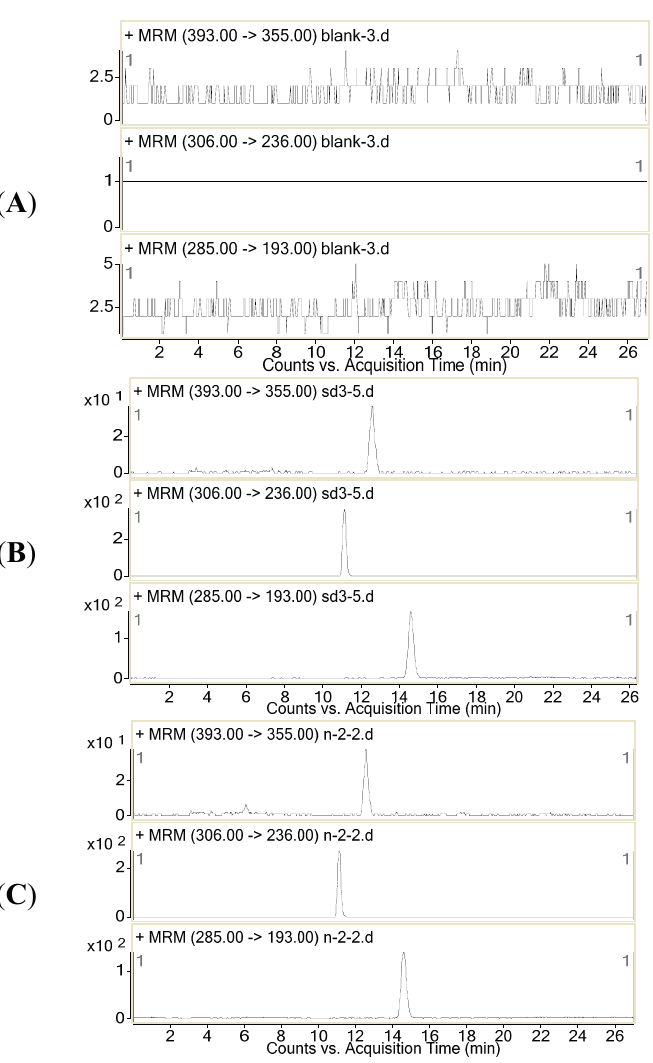
Figure 2. Representative SRM chromatography of ( A ) a plasma sample; ( B ) a blank plasma spiked with diazepam, dexamethasone and the IS; ( C ) a rat plasma sample collected 0.5 h after drug